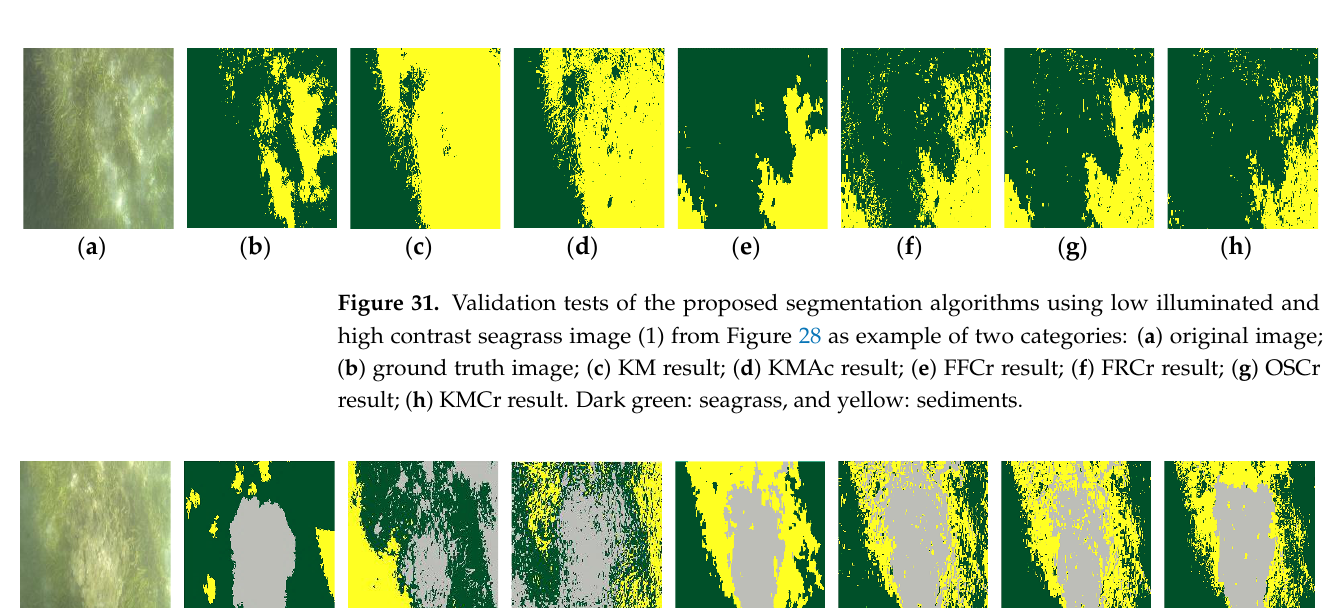
Figure 32. Validation tests of the proposed segmentation algorithms using low illuminated and high